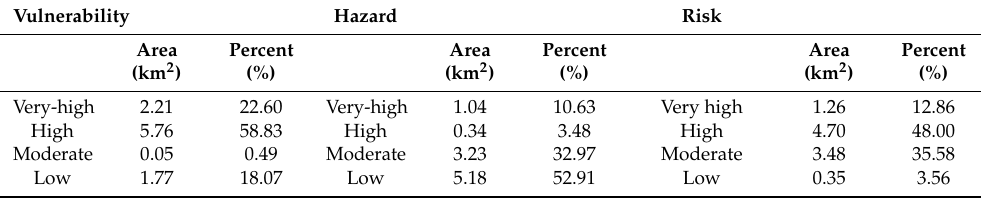
Table 3. Distribution of validated Vulnerability, Hazard and validated Risk in the study